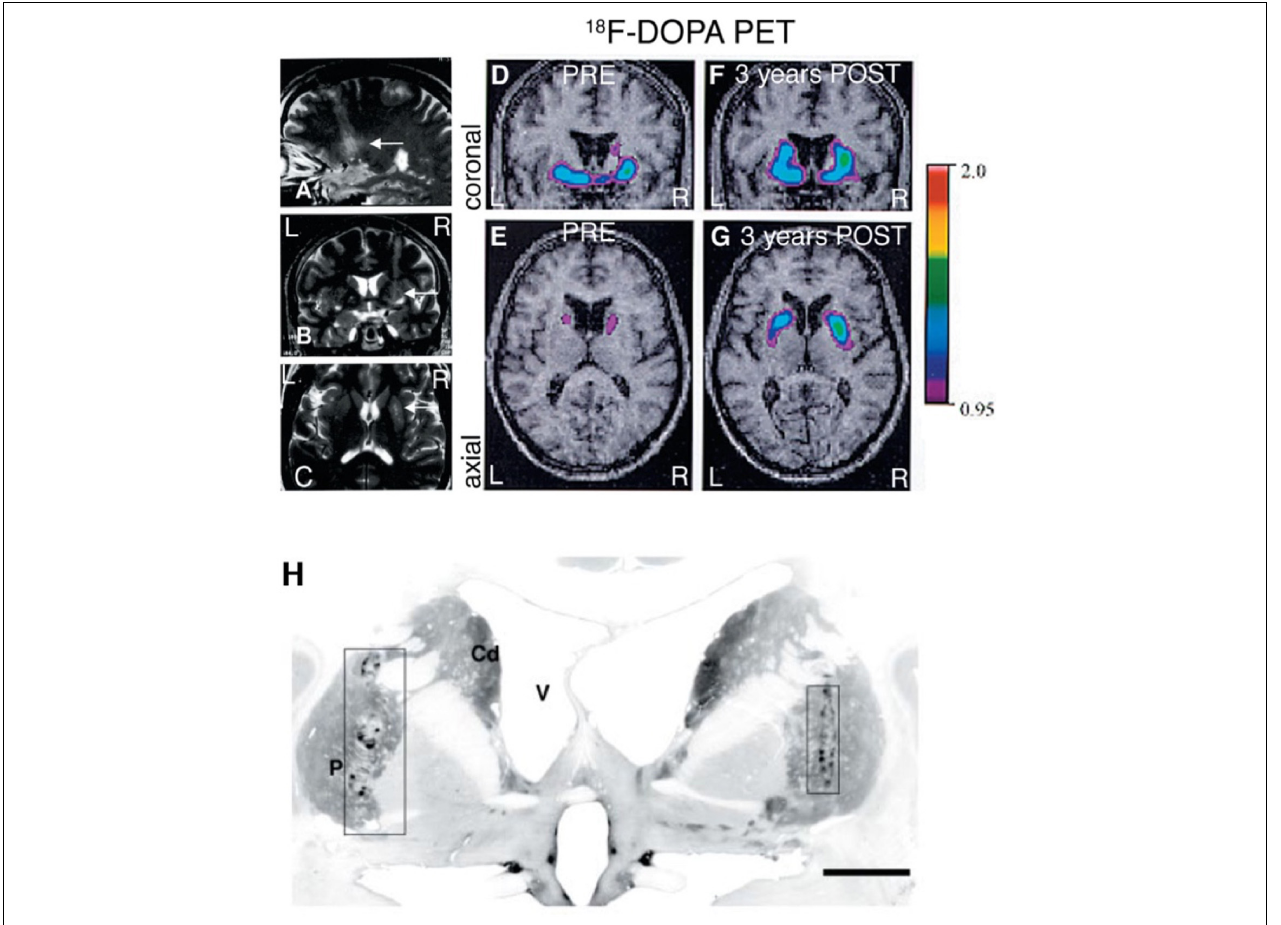
FIGURE 2 | Fetal VM grafts. (A–C) MRI 24 h after fetal VM transplantation surgery in the right putamen showing the 4 needle tracks. (D,E) Preoperative PET scan showed a marked, asymmetrical decrease in putaminal18F-DOPA uptake, consistent with the diagnosis of idiopathic PD. (F,G) 3 years after transplantation the PETs show a significant increase in 18F-DOPA uptake. (H) TH immunostaining of the grafts 4 years after transplantation. (P = putamen; Cd = caudate nucleus; V = lateral ventricle. Scale bar: H , 1 cm). Figure originally published in Mendez et al. (2005). Reused by permission of Oxford University